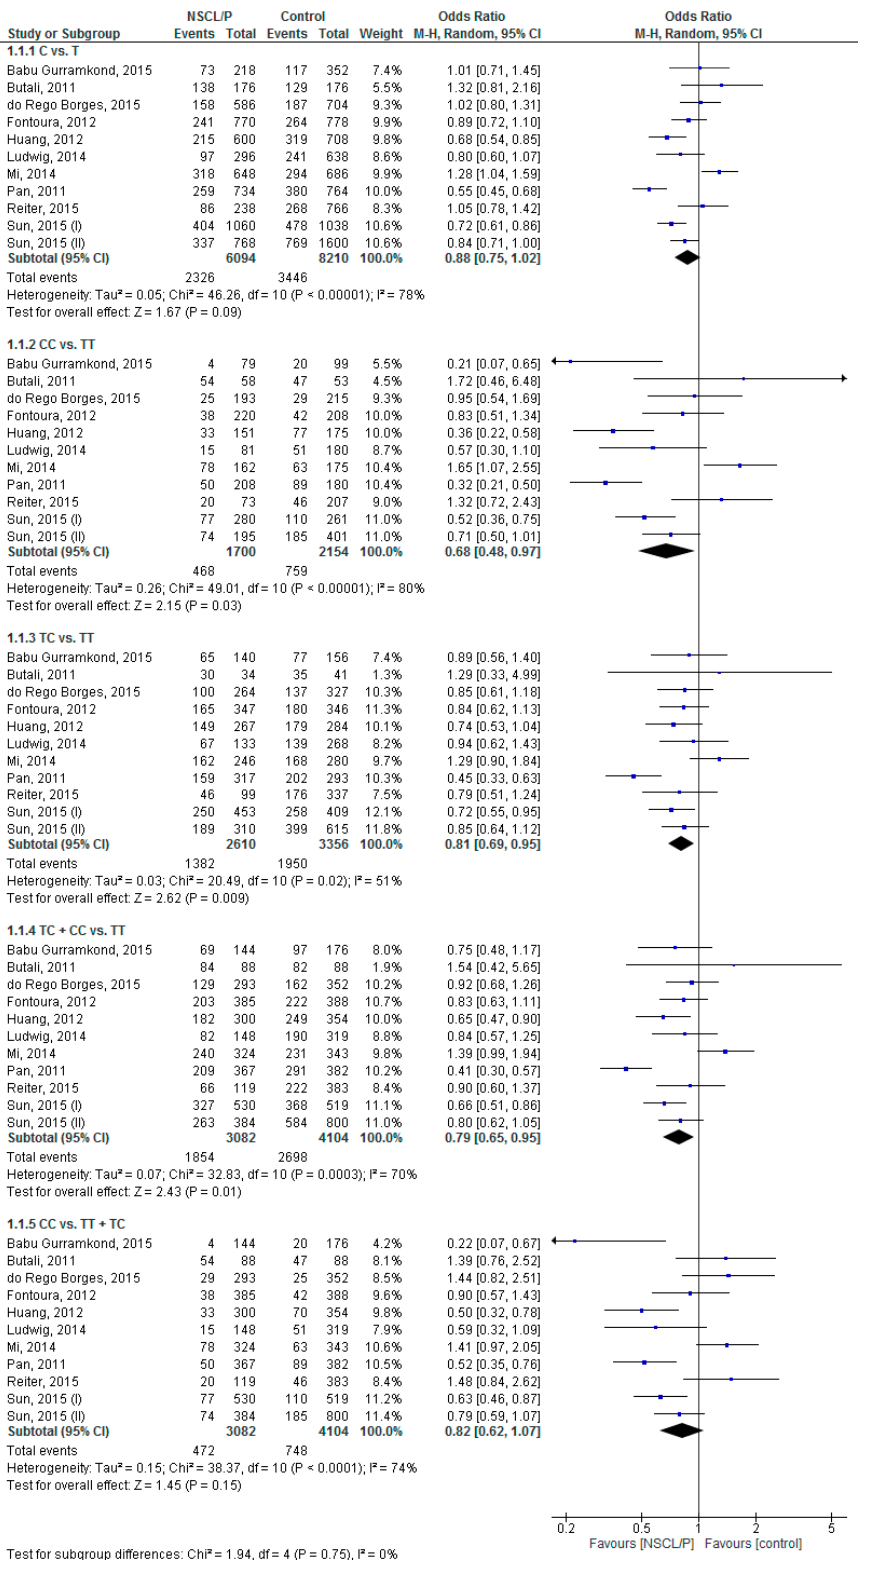
Figure 2. Forest plot of the odds ratio of the risk of non ‐ syndromic cleft lip/palate related to rs13041247 MAFB polymorphism.